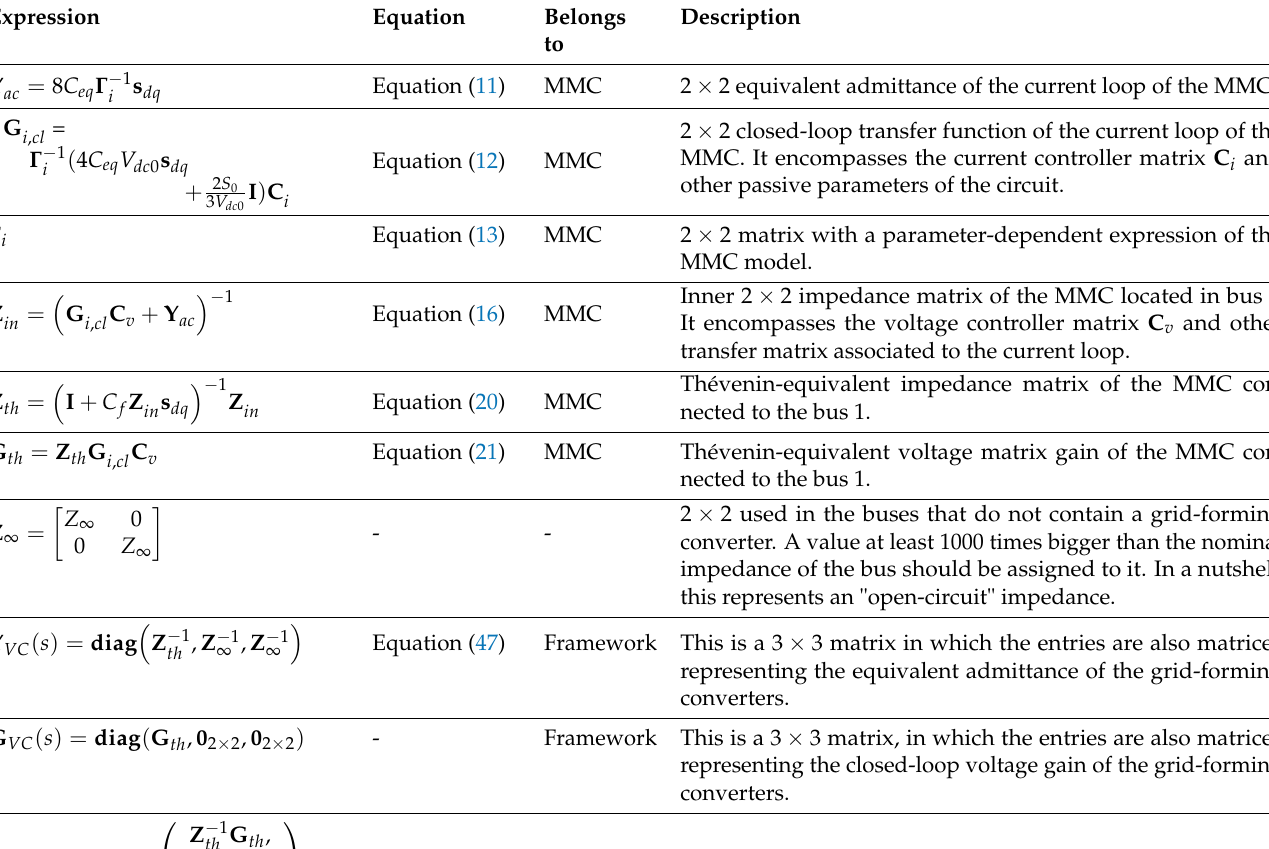
Table A4. Summary of the major equations in the test case of Section